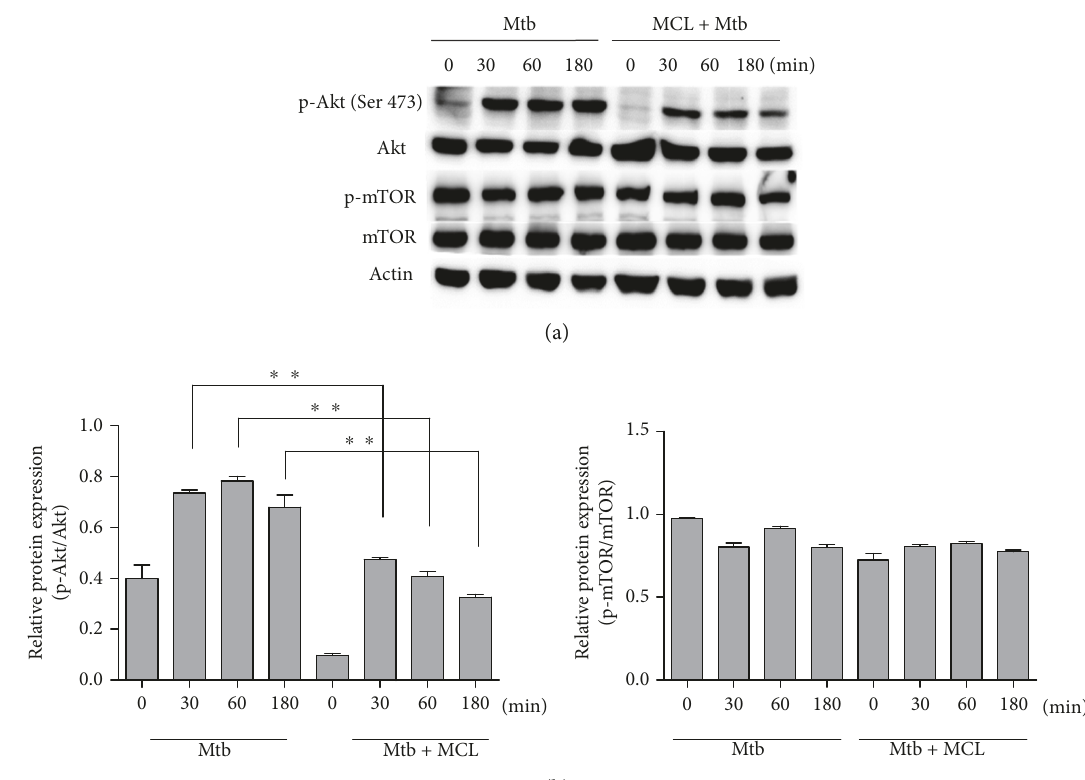
Figure 6: MCL inhibits the phosphorylation of Akt. Raw264.7 cells (1 × 10 6 /well) were seeded in 6-well plates overnight and subsequently infected with Mtb for 4hr. After washing with PBS, cells were treated with or without MCL (10 μ M) for 30, 60 or 180 min. The protein level of Akt, p-Akt (Ser 473), mTOR, p-mTOR, and β -actin were detected by Western blot (a). The bar graphs showed the statistical results for phosphorylation levels of Akt and mTOR (b). Data are shown with the means ± SD ( n ≧ 3 ). ∗∗ p < 0 01